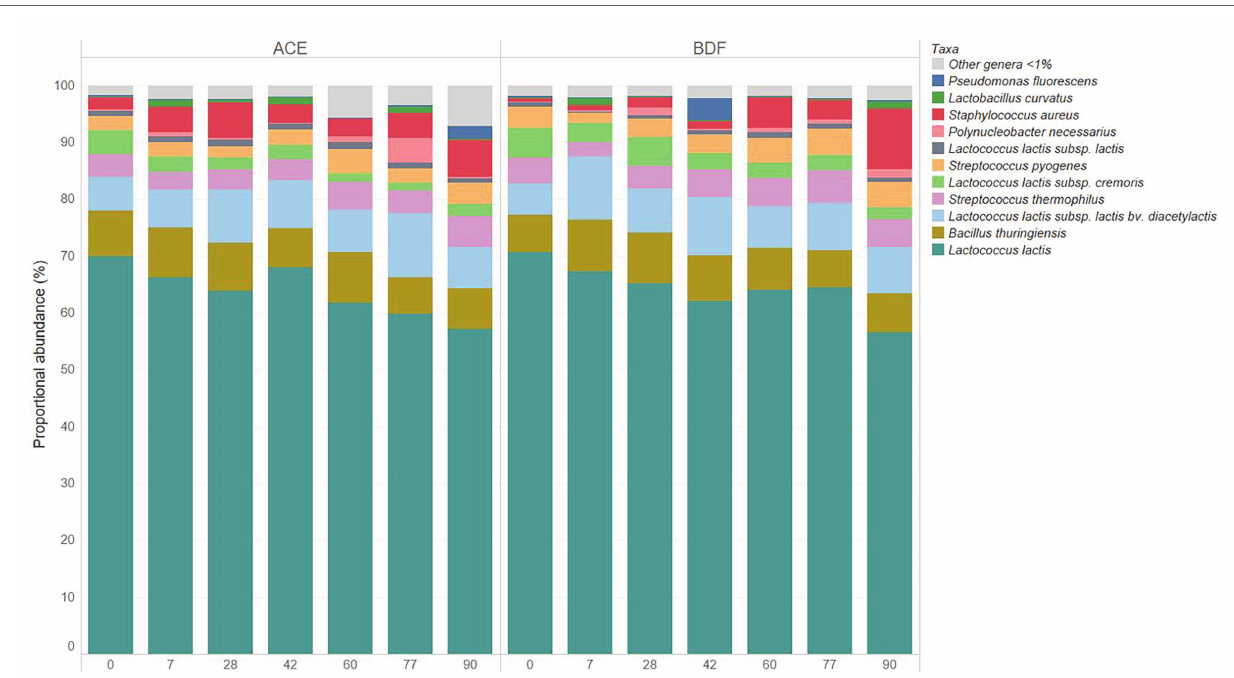
TABLE 3 | Pairwise Adonis of the six individual Gouda cheeses (A, B, C, D, E, and F) as well as the two types of cheeses (ACE, uninoculated and BDF, inoculated) manufactured in this study.